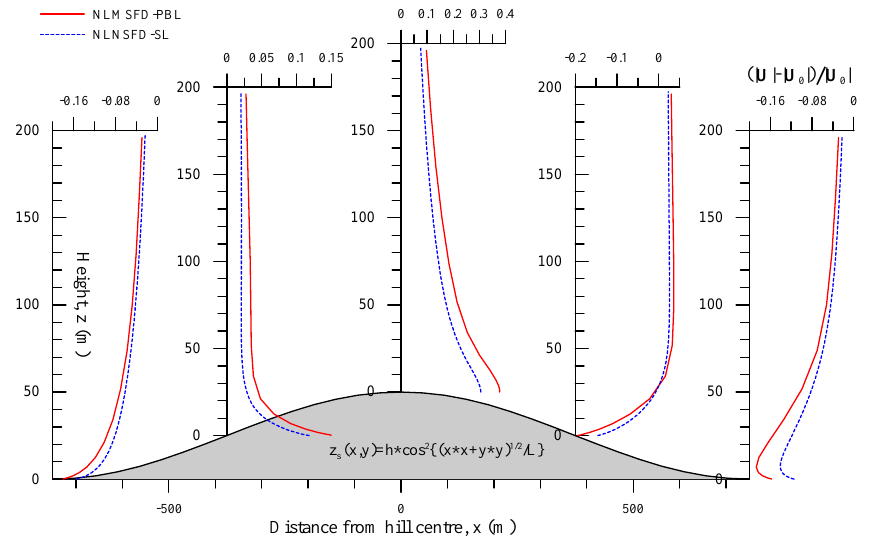
Figure 2. Comparison of vertical fractional speed-up profiles at five different locations along the central line ( y = 0) of a circular cosine-squared hill from NLMSFD-PBL and NLMSFD-SL model runs. a depth of about 40 m (where TKE is about 90% of its surface value). Above this surface layer, the mean wind profiles show a smooth blending to geostrophic values at the upper boundary layer of the model. The PBL has a depth of about 900 m. The turbulent quantities (TKE